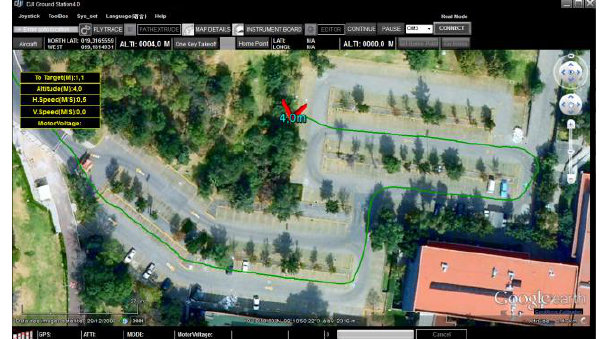
Figure 1. Spreading Wings S800 hexacopter with the Sony Nex- 7 camera